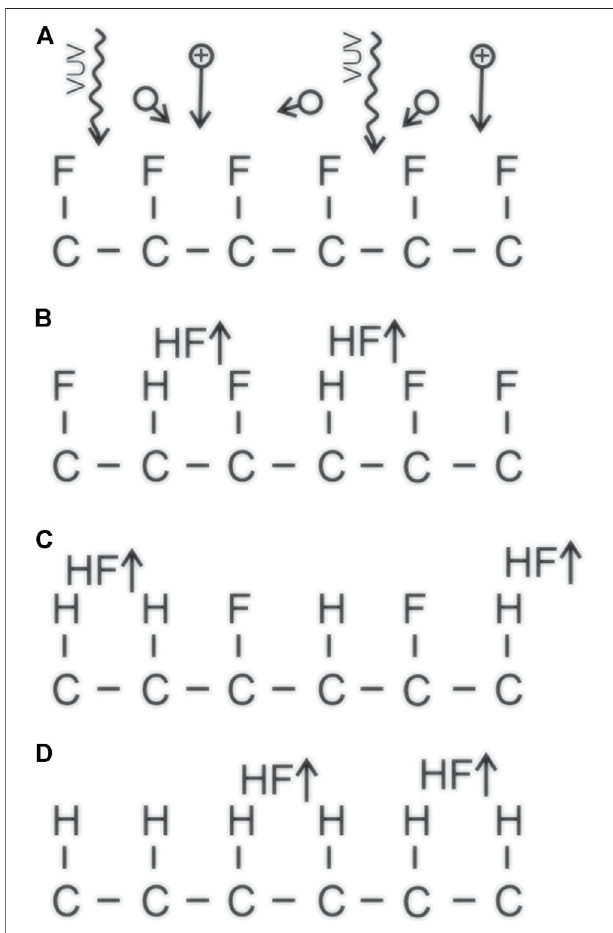
FIGURE 6 | Illustration of the interaction between hydrogen plasma and surface of fl uorinated polymers. (A) pristine polymer is exposed to VUV radiation, positively charged ions and neutral atoms; (B) some F atoms are substituted by H atoms, and an HF molecule is desorbed; (C) more F atoms are substituted with H atoms; (D) a polyole fi n-like surface layer is formed.